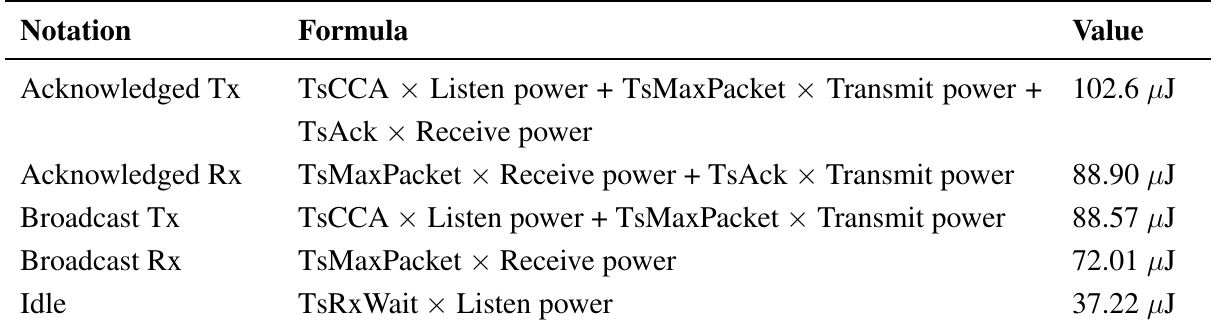
Table 5. Energy-consumption per transaction.